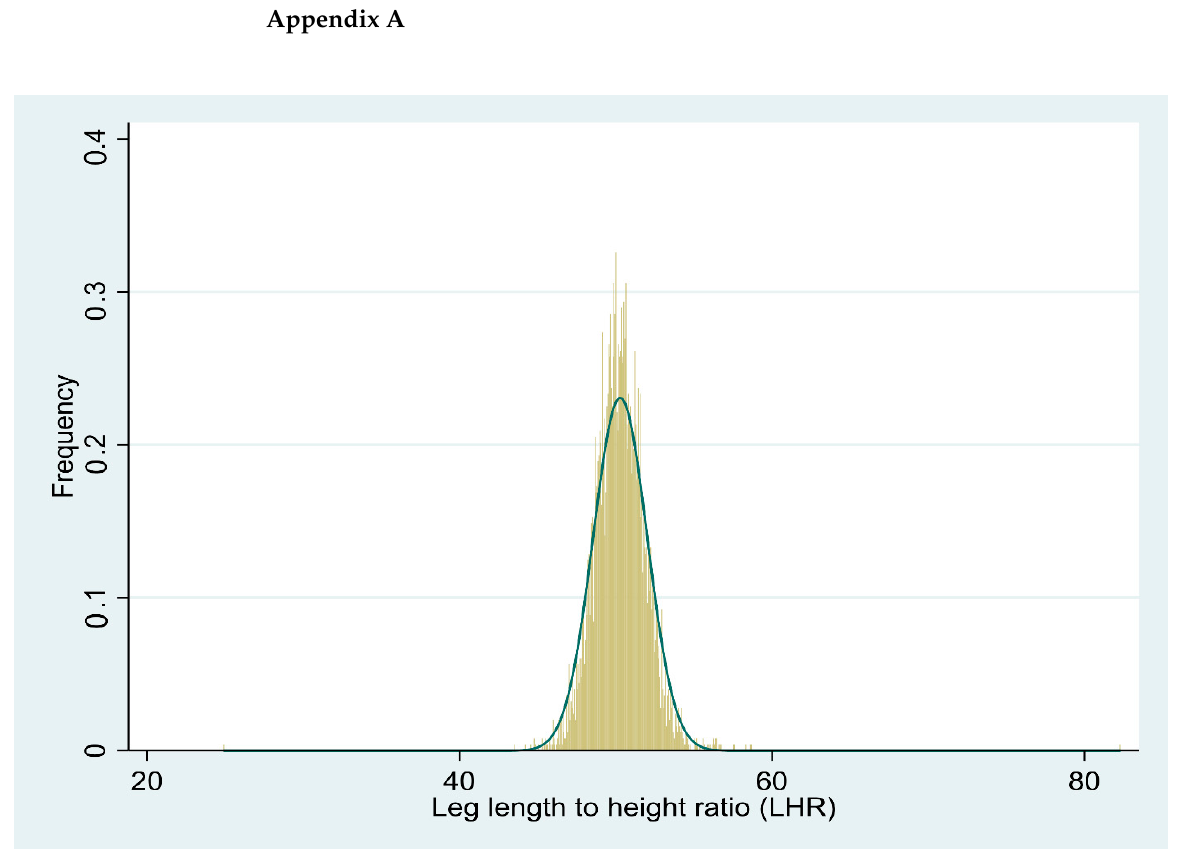
Figure A1. Distribution Plot of the Continuous Variable Leg-Length to Height Ratio (LHR) with a Normal-Density Curve.